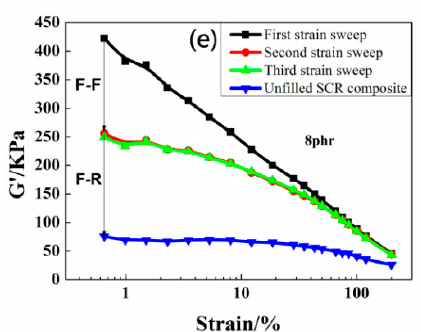
Figure 3. The three times G’-strain curves of the CB/NR rubber composites with different contents of OMMT. The content of OMMT: ( a ) 0 phr, ( b ) 2 phr, ( c ) 4 phr, ( d ) 6 phr, ( e ) 8 phr.